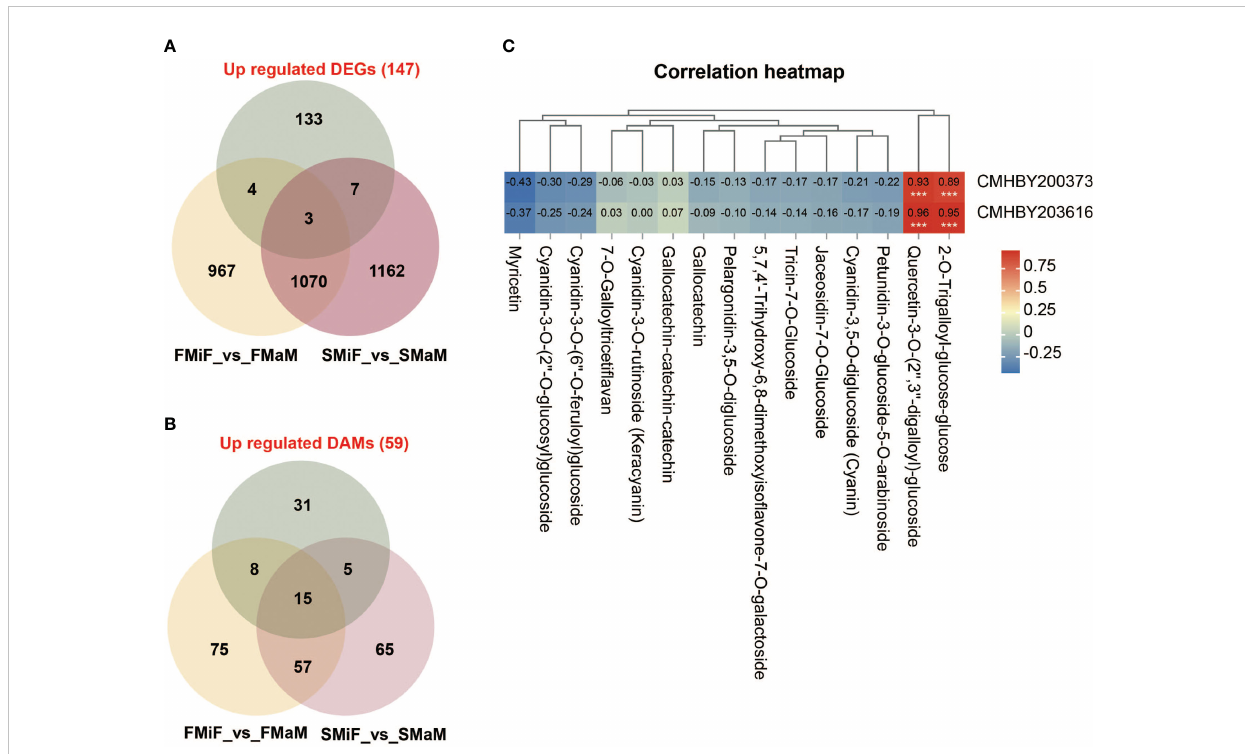
FIGURE 8 MYB305 transcription factor and fl avonoids are involved in sexual differentiation of chestnut. (A) A Venn diagram of the association between 147 co- upregulated genes and male and female fl ower sex differences. (B) A Venn diagram of the association between 59 co-upregulated metabolites and male and female fl ower sex differences. (C) Heat map of the correlation between 2 genes and 15 fl avonoid metabolites. Among them, CMHBY204070 gene was excluded due to FPKM value